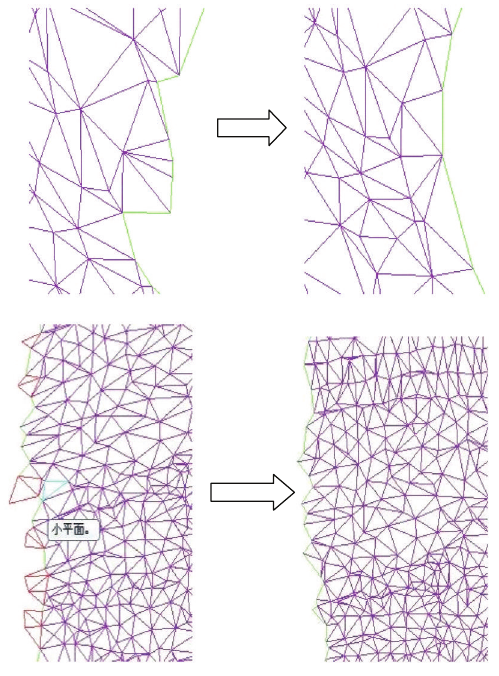
Figure 9: The smoothing operation of one specific spatial grid of target kinetic energy distribution surface model.